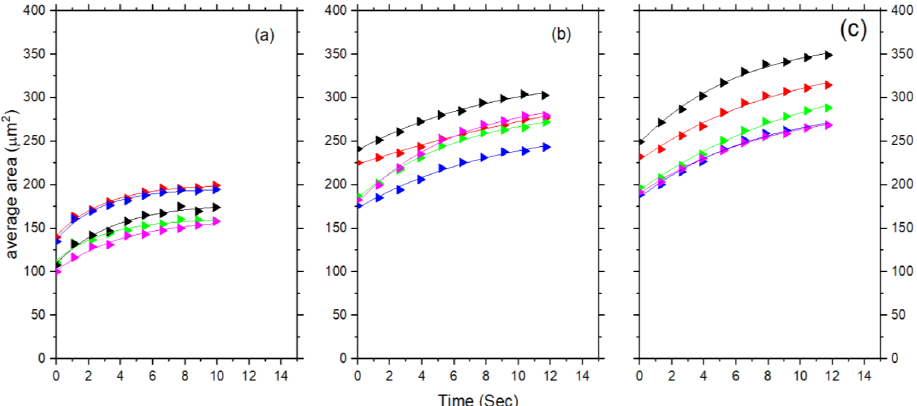
Figure 6. Size distribution of the mean area of the cells as a function of the time for untreated ( a ), 3 h treated ( b ) and 6 h treated ( c ) at 300 (red), 900 (blue), 1500 (green), 2100 (magenta) and 2700 mW (black)